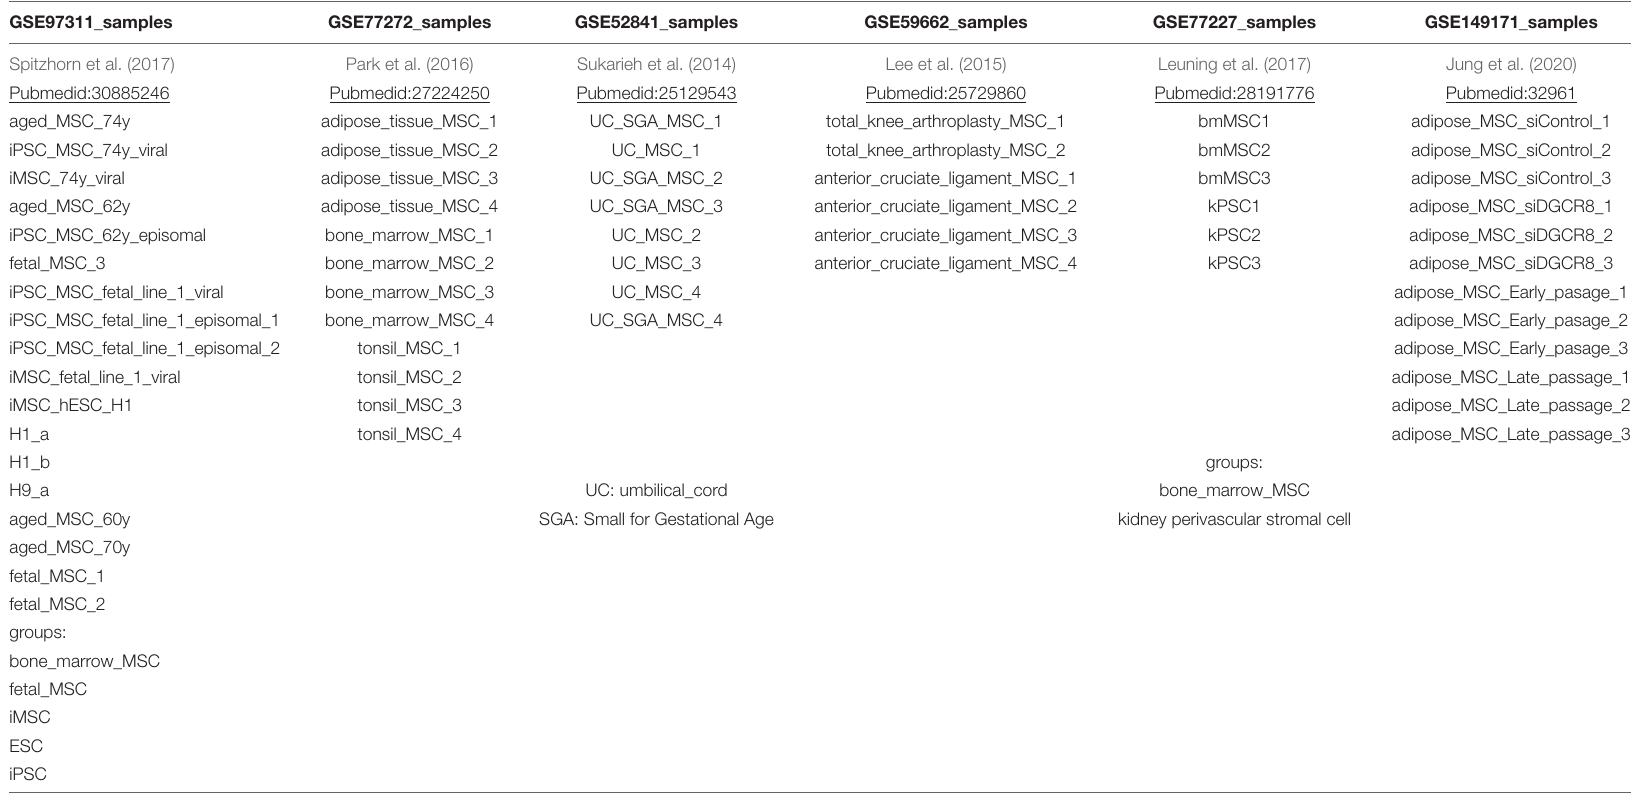
TABLE 1 | Samples on platform Illumina Human HT-12. GSE97311_samples GSE77272_samples